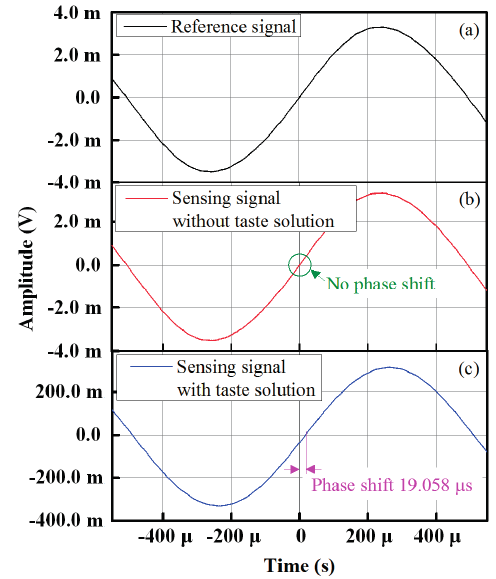
Figure 7. Waveform response of sensing and the reference signals: ( a ) reference signal; ( b ) response before injecting taste solution; and ( b ) response with taste